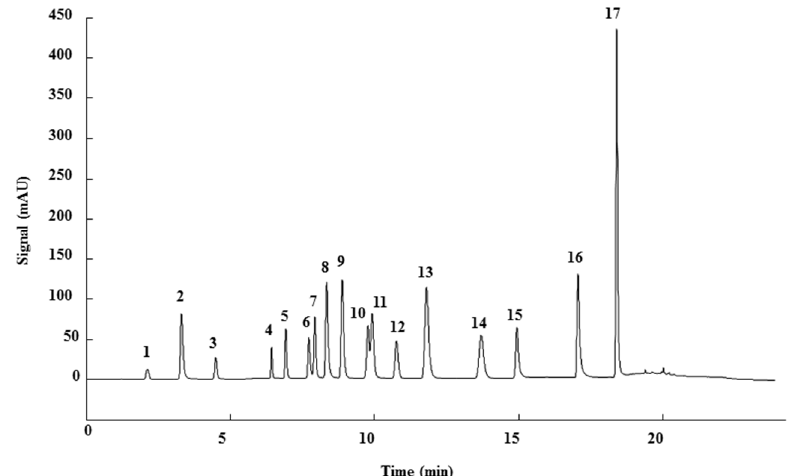
Figure 1. HPLC-UV chromatogram of a 15 mg/L standard solution of the 17 targeted phenolic compounds under optimal gradient elution conditions at 280 nm. Peak identification as in Table 1.